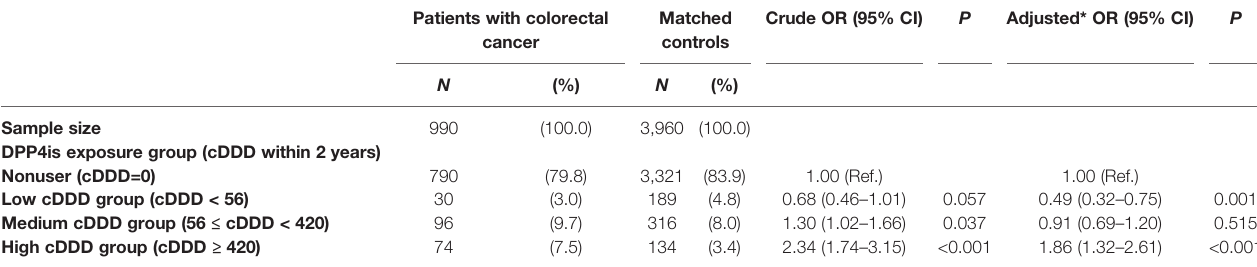
TABLE 3 | Association between DPP4is exposure and colorectal cancer risk among patients with T2DM receiving second-line therapy. Patients with colorectal cancer